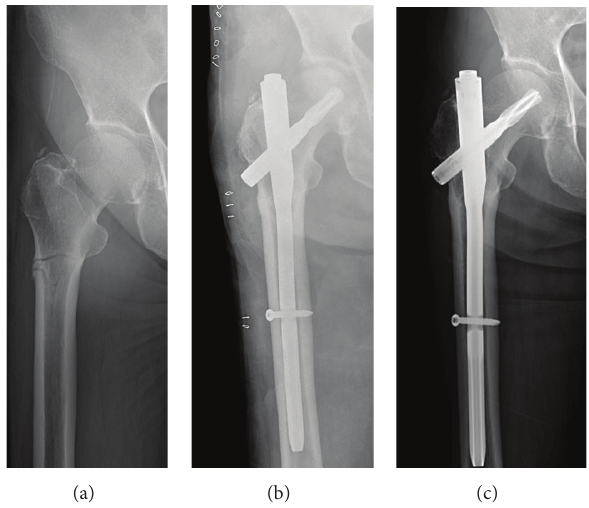
F 1: (a) A 72-year-old woman had pain in her right thigh with a transverse fracture line and thickening of the lateral cortex in the subtrochanteric area. (b) She underwent internal �xation using a proximal femoral nail. (c) At 13 weeks postoperatively, she had no pain with a dissolution of the fracture line at the lateral cortex.